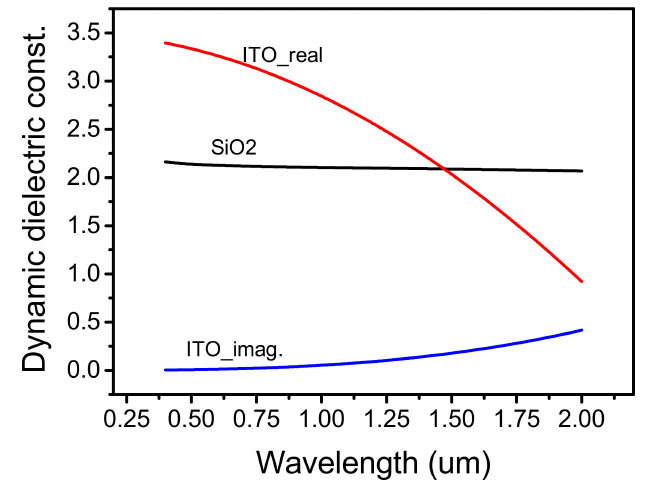
Figure 2. Dynamic dielectric constant dispersion curves of indium tin oxide (ITO) and silicon dioxide (SiO 2